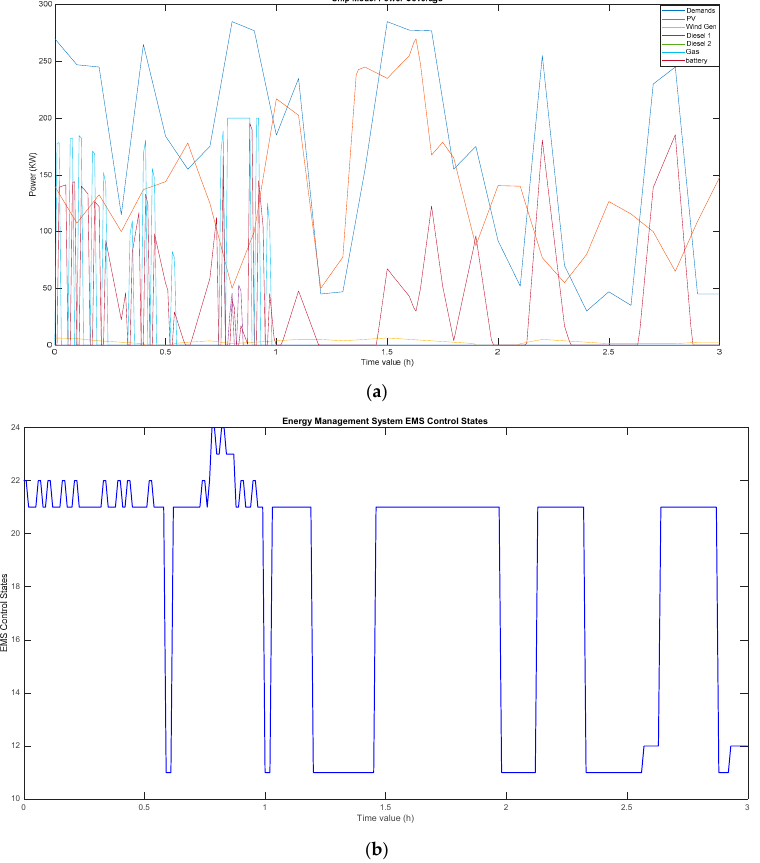
Figure 13. ( a ) Ship power generation and consumption during Scenario 4. ( b ) EMS Control States. Load Demands (blue), DG1 (purple), LNG (light blue), DG2 (deactivated), PVs (brown), WECs (yellow).